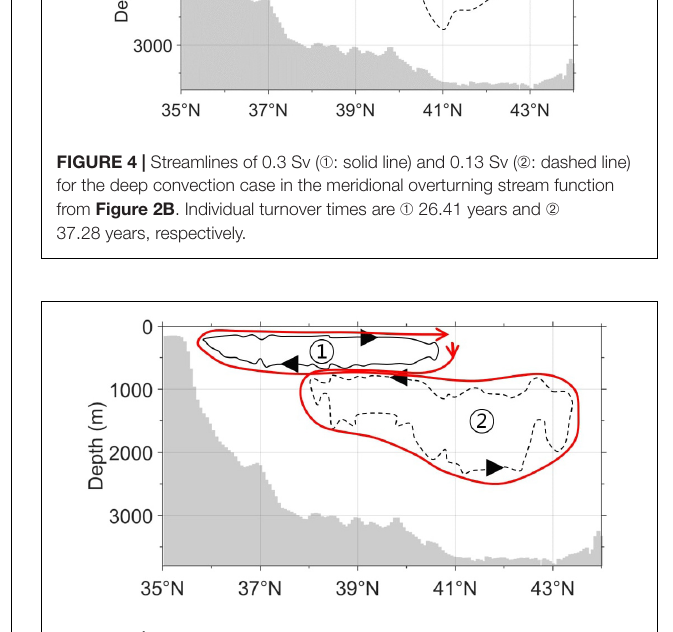
FIGURE 5 | Streamlines of 0.2 Sv ( (cid:192) : solid line) and − 0.3 Sv ( (cid:193) : dashed line) for the shallow convection case in the meridional overturning stream function from Figure 2C . Turnover times are (cid:192) 8.68 years, (cid:193) 36.76 years, and (cid:192) + (cid:193) 45.44 years,